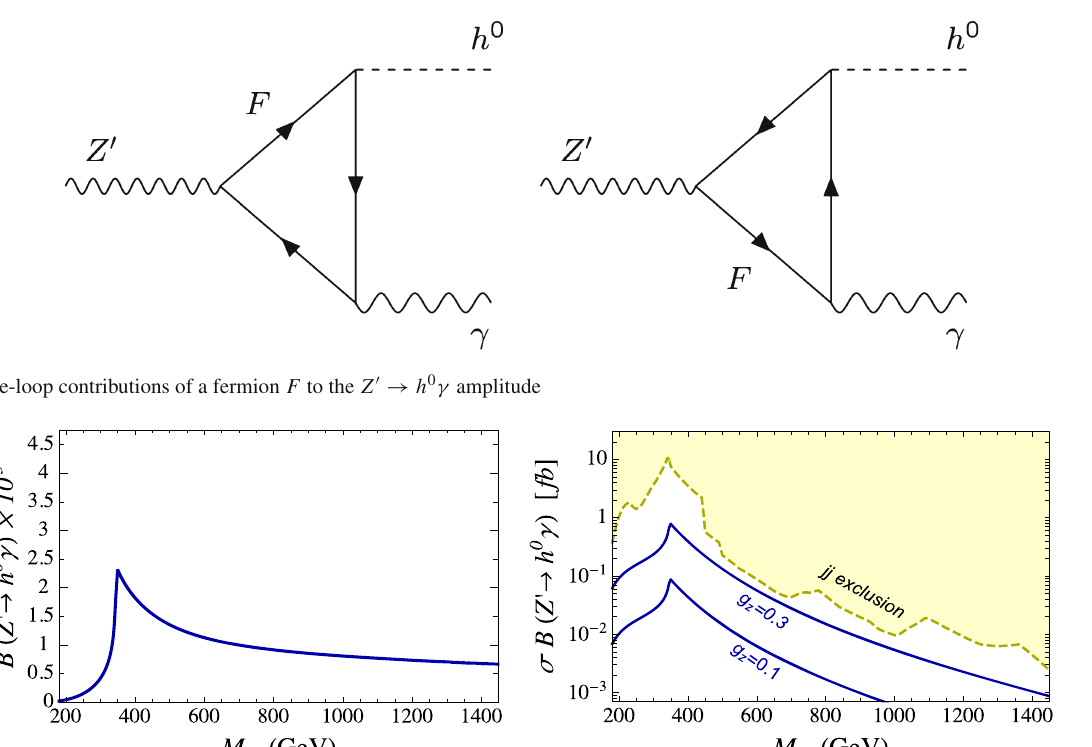
for two values of the gauge couplings g z , when all the SM quarks have charge z F = 1 / 3 under the new gauge group. The shaded region is ruled out by current dijet resonance √ s = 13 TeV